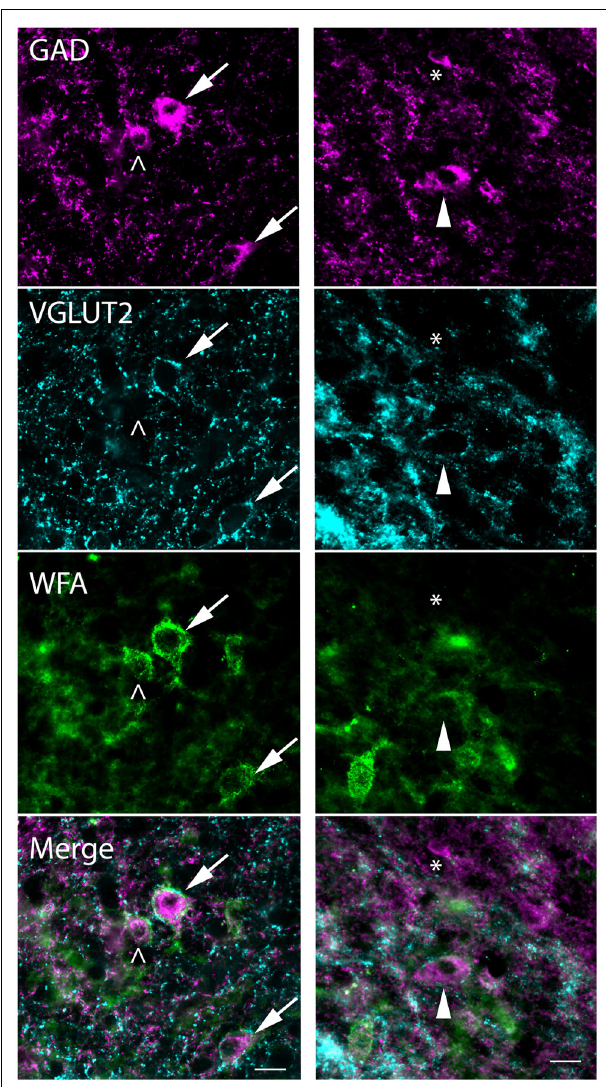
FIGURE 10 | Photomicrographs showing association of PNs and VGLUT2-immunopositive perisomatic bouton rings with GAD+ cells. Examples are shown from the ICd (left column) and ICc (right column). Each column shows a region stained for GAD (top row),VGLUT2 (second row), andWFA (third row). Bottom row: merged images showing all three markers. GAD cells, top row, are indicated by four different symbols that represent the four possible relationships with PNs andVGLUT2 rings. Arrows (left column) show GAD + cells that haveVGLUT2 + rings and WFA-stained PNs. Open arrowhead (left column) shows a GAD + cell that lacks aVGLUT + ring but is surrounded by a PN. Solid arrowhead (right column) shows a GAD + cell that is surrounded by aVGLUT2 ring but lacks a WFA-stained PN. Asterisk (right column) is adjacent to a small GAD + cell that has neither a PN nor aVGLUT2 ring. Note that one PN (bottom left corner of the right column) surrounds a GABA-negative cell. Scale bar = 20 μ m. Case